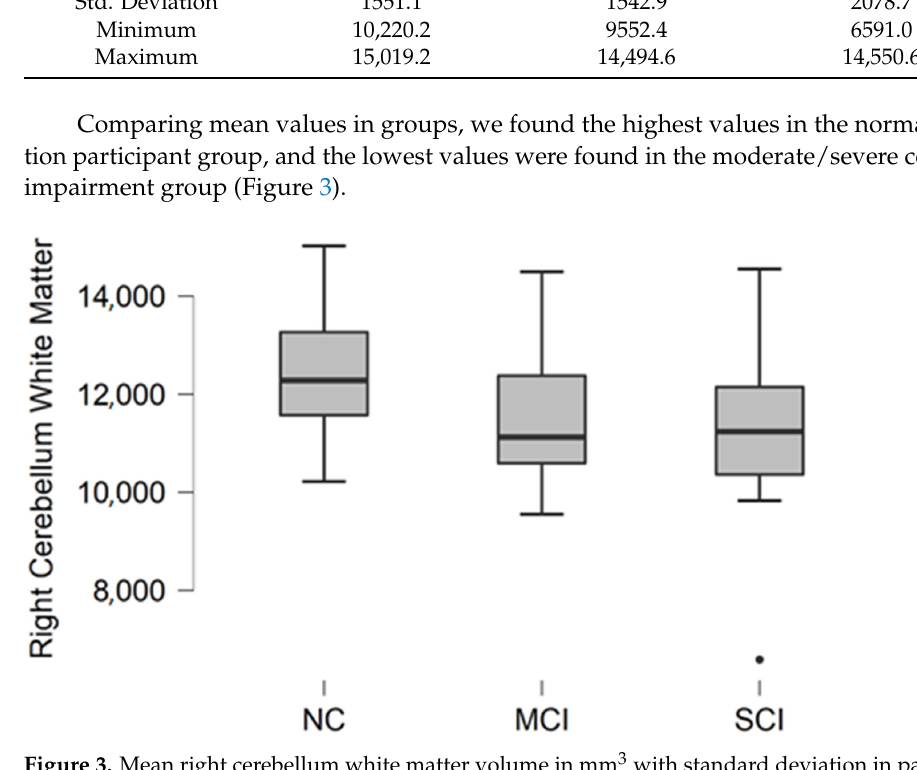
Table 4. Descriptive statistics for right cerebellum white matter volume in participants with normal cognition (NC), mild cognitive impairment (MCI), and moderate/severe cognitive impairment (SCI).